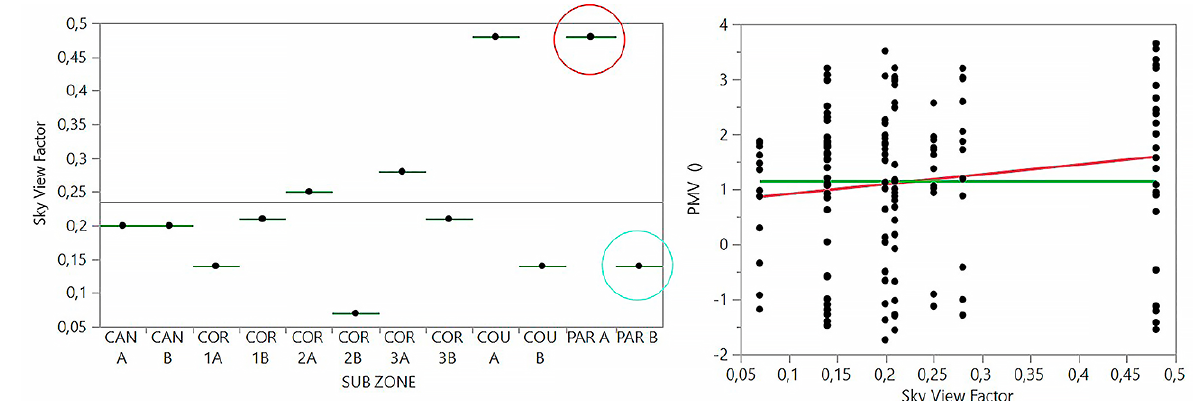
Figure 10. (a) Average of Sky View Factor in Sub Zone; (b) regression value between Sky View Factor and PMV